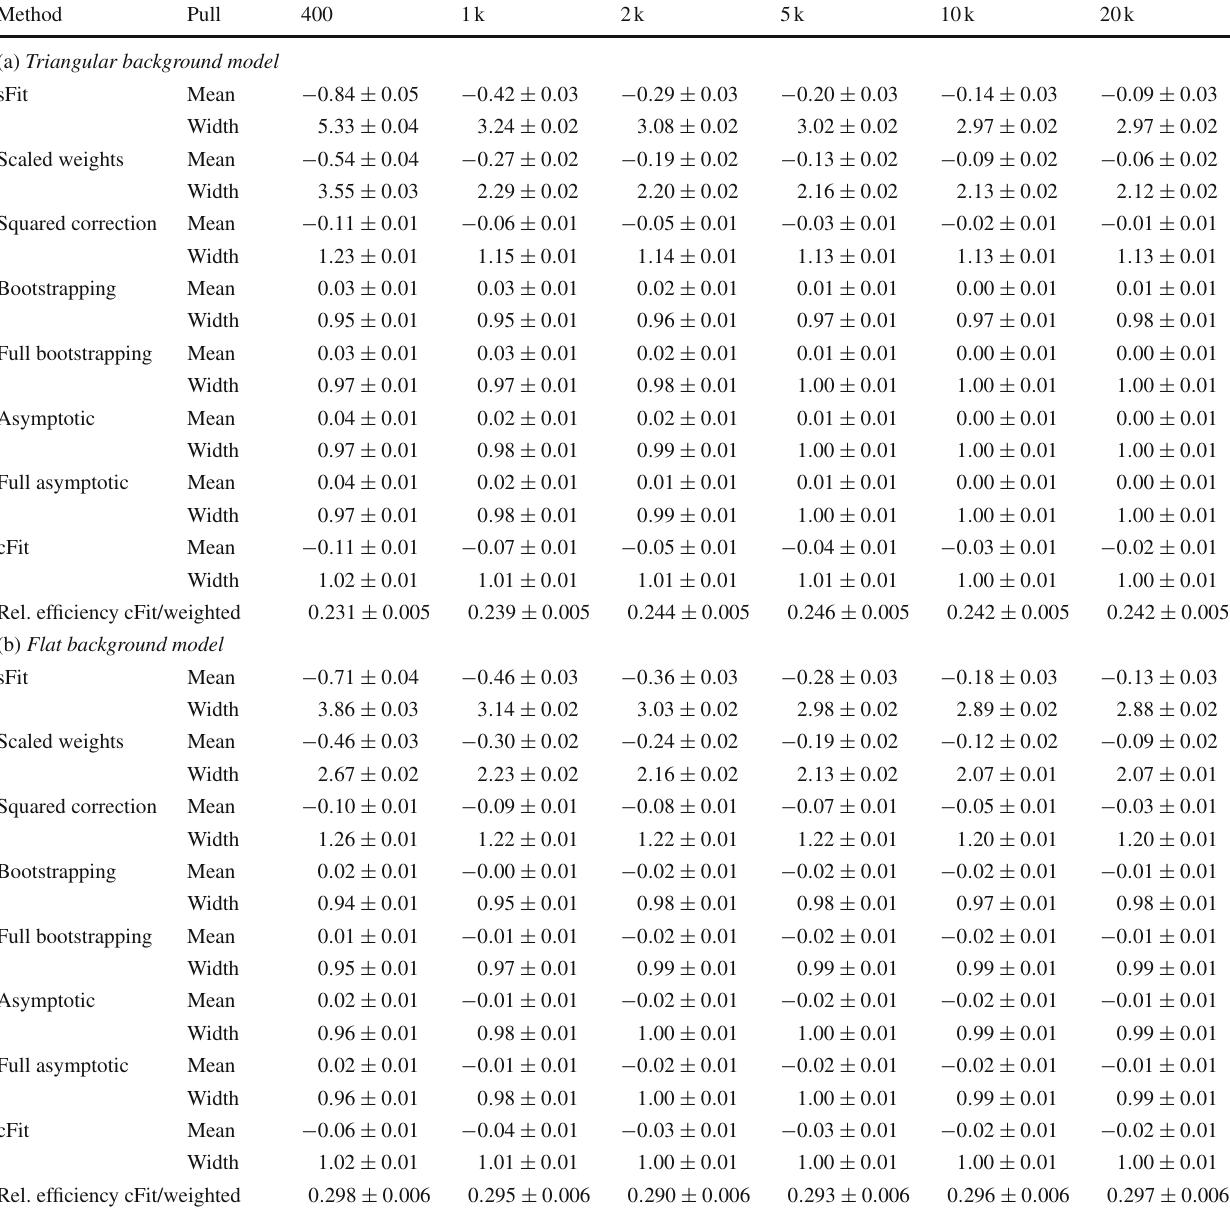
given. The different tables shown correspond to the different back- ground models as specified in Sect. 4. In this case, the mass range [ 5267 , 5467 ] MeV / c 2 is chosen, such that the nuisance parameter α has negligible correlation with the event